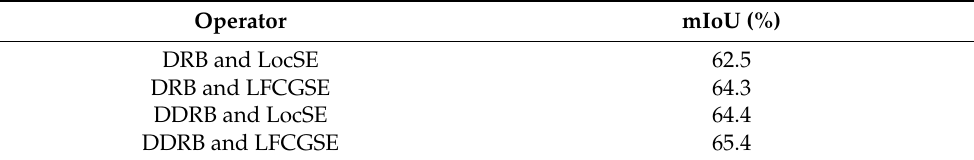
Table 3. Ablation